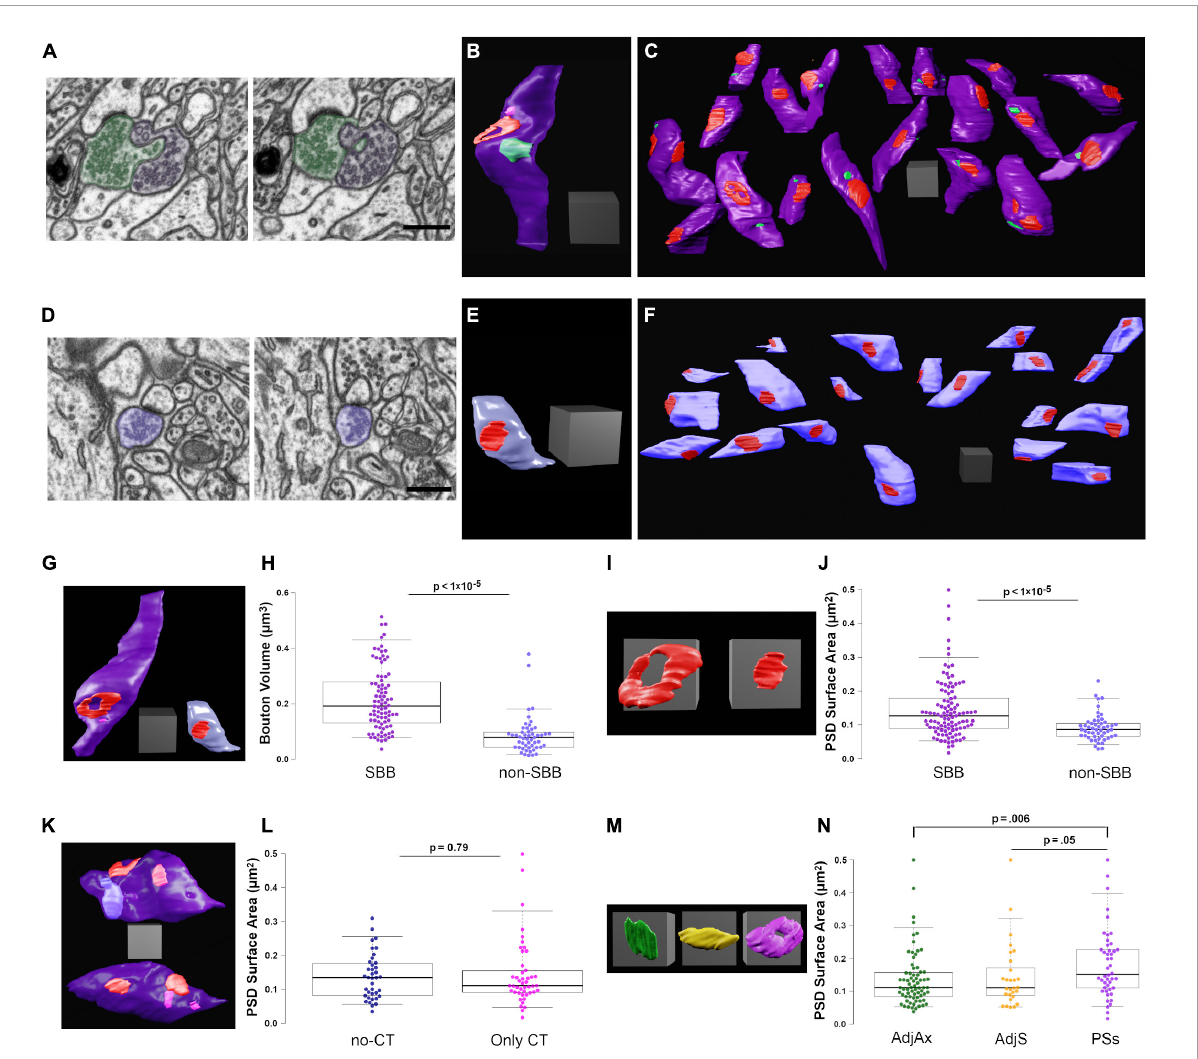
FIGURE3 Spinule-bearing presynaptic boutons (SBBs) are larger and stronger than presynaptic boutons without spinules (non-SBBs). (A) Successive FIB-SEM images showing a spinule from an adjacent presynaptic bouton (AdjAx; green) with a spinule projecting into and enveloped by an SBB (purple). (B) 3D reconstruction of the same SBB (purple) and AdjAx spinule (green) as shown in panel (A) , displaying an annulus-shaped perforated PSD (red) and a CT spinule (pink) from a postsynaptic spine (not shown). (C) Field of 19 3D reconstructed SBBs (purple) in their approximate neuropil locations within the FIB-SEM image stack; some non-SBBs have been rotated to display their PSDs (red) and spinule invagination sites (green). (D) Successive FIB-SEM images showing a presynaptic non-SBB (light blue) with a synapse (dark PSD above bouton) onto a postsynaptic spine. Note that this postsynaptic spine is enveloped by an inhibitory presynaptic bouton (top of right FIB-SEM image) and has a long no-CT spinule into this inhibitory bouton (see yellow spinule in Figure 1G 5 ). (E) 3D reconstruction of the same non-SBB (light blue) and PSD (red) as shown in panel (D) . (F) Field of 20 non-SBBs (light blue) in their approximate neuropil locations within the FIB-SEM image stack; some SBBs have been rotated to display their PSDs (red). (G) Same 3D reconstructions of SBB and non-SBB shown in panels (B,E) , shown side by side for comparison. (H) Box plots showing the presynaptic bouton volume for SBBs and non-SBBs ( n = 87 and 51, respectively). For all boxplots, center lines show medians, box limits indicate the 25th and 75th percentiles, whiskers extend to the 5th and 95th percentiles, width of boxes is proportional to the square root of the sample size, and raw data points are plotted as filled circles. (I) Zoomed-in view of the 3D reconstructions in panel (G) showing PSDs from an SBB (left) and a non-SBB (right). (J) Boxplots of PSD surface area for SBBs and non-SBBs ( n = 107 and 52, respectively). (K) 3D reconstructions of SBBs with no-CT (above, light blue) and CT (below, pink) spinules, displaying their PSDs (red). (L) Boxplots of PSD surface area for SBBs with only no-CT spinules and SBBs with only CT spinules. (M) 3D reconstructions of representative PSDs from SBBs containing AdjAx (green), adjacent spine (AdjS, yellow), and postsynaptic spine (PSs, magenta) spinules. (N) Boxplots of PSD surface area for SBBs containing spinules from AdjAx, AdjS, and PSs origins. Scale bars (A,D) 0.5 µ m; All scale cubes = 0.5 µ m per side.